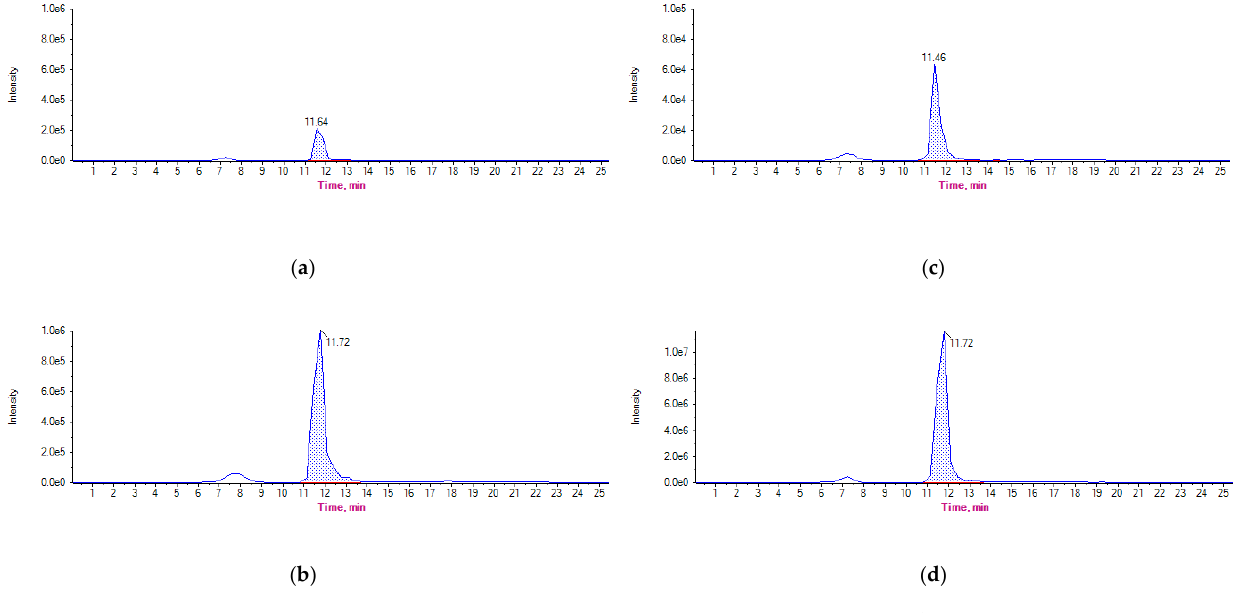
Figure 4. Chromatograms of OTC (461.0/261.0) from ( a ) droppings fortified at 50 µg kg −1 , ( b ) experimental droppings sample from group A day 1 post the end of treatment, ( c ) litter sample fortified at 50 µg kg −1 and ( d ) experimental litter sample from group A day 1 post the end of treatment.